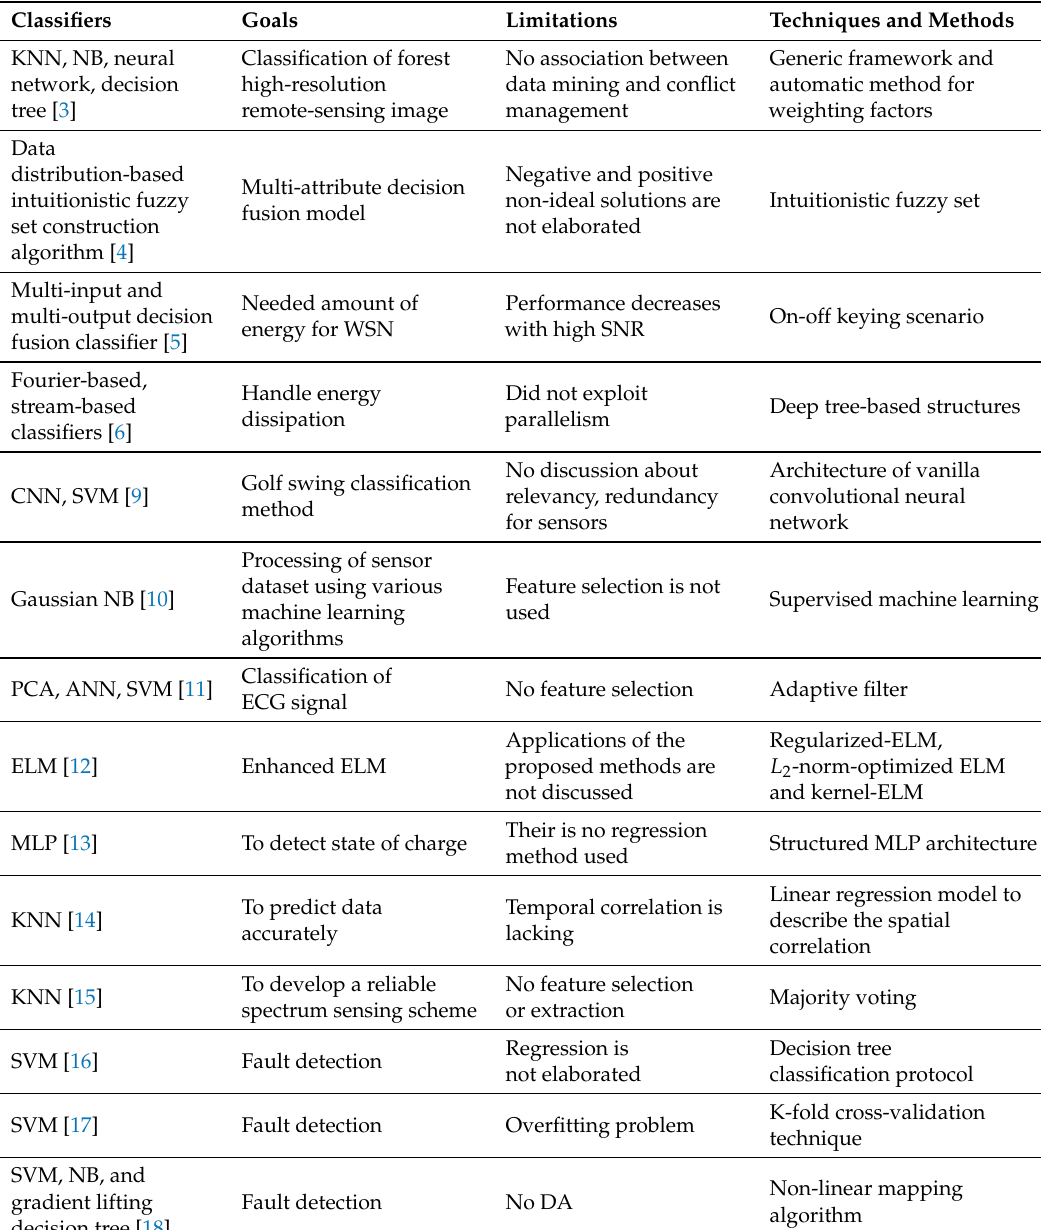
Table 1. Related